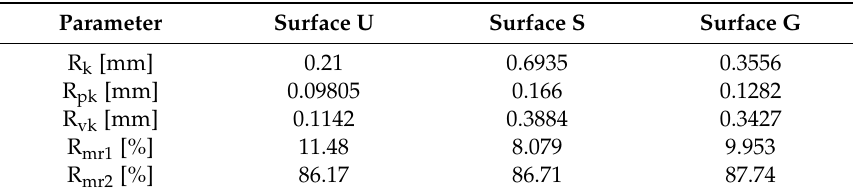
Table 1. Roughness profile